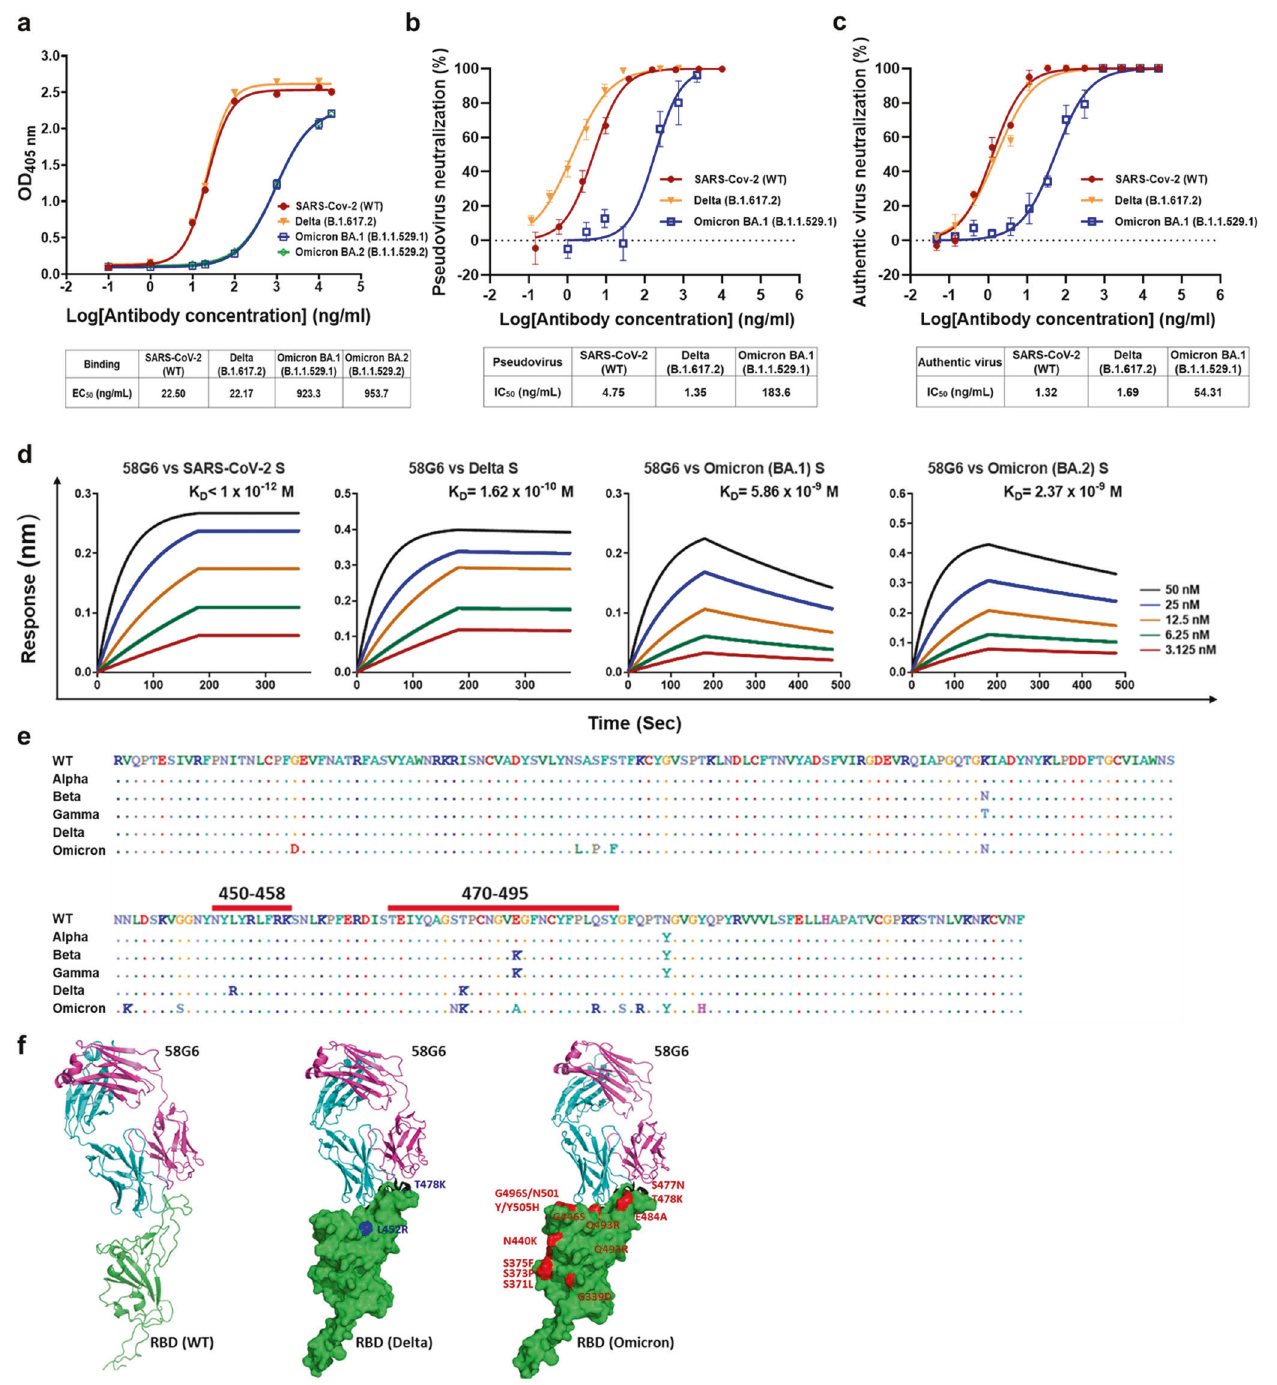
Fig. 1 Activities of 58G6. a Binding of 58G6 to different RBDs, including SARS-CoV-2 WT, Delta, Omcrion BA.1 and BA.2, as measured by ELISA. b Neutralization of pseudotyped SARS-CoV-2 WT, Delta and Omcrion BA.1 by 58G6. Inhibitory rates of infection were calculated by scanning fl uorescent plaques. c Evaluation of the neutralization activity of 58G6 against live SARS-CoV-2 WT and the Delta and Omicron variants. d The af fi nities of 58G6 for S proteins of SARS-CoV-2, Delta, Omicron BA.1 and Omicron BA.2 measured by BLI. e Binding regions of 58G6. RBDs from WT SARS-CoV-2 and the Alpha, Beta, Gamma, Delta and Omicron variants are aligned. The red lines indicate the binding regions (450 – 458, 470 – 495) of 58G6. f Structure of the complex of 58G6 Fab bound onto the SARS-CoV-2 RBD. On the left, the secondary structure elements of the RBD and heavy and light chains of 58G6 Fab are colored green, cyan and violet, respectively. The surface of the RBD is colored green. The mutated residues of the Delta variant are colored blue (middle), while those from the Omicron are colored red (right)